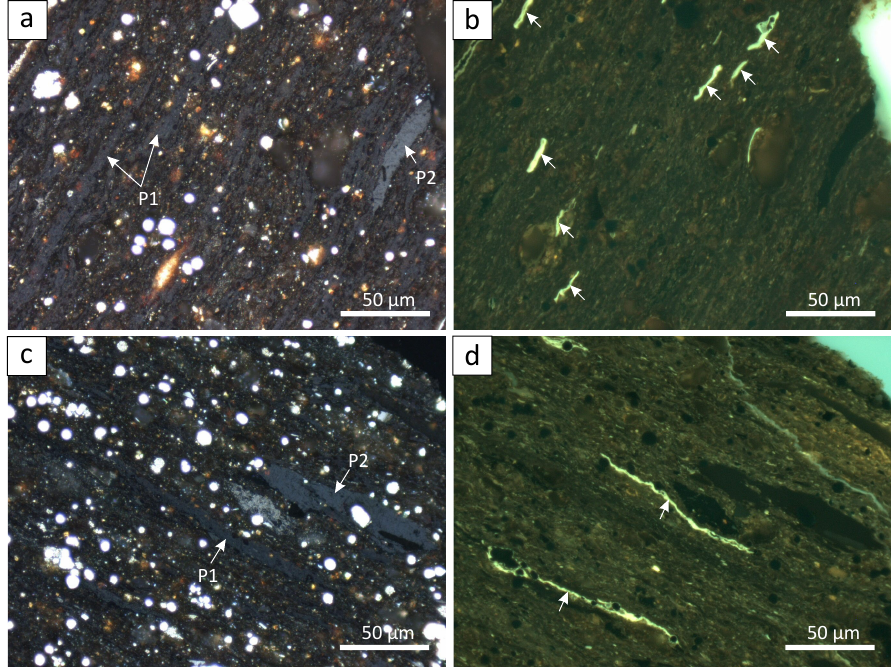
Figure 3. The organic petrography photomicrographs of the studied samples from the Lower and Upper Bakken Formation: the two left images were taken during oil immersion under a white incident light, while the two right images show same view but taken under ultraviolet (UV) light with a × 50 objective. All samples were organic-rich pyritic shale with abundant matrix bituminite and solid bitumen ( a , c ) and green fluorescing unicellular alginate macerals (shown with white arrows) within the matrix ( b , d ). P1 and P2 represent the two populations of bitumen with their distinct reflectance values.